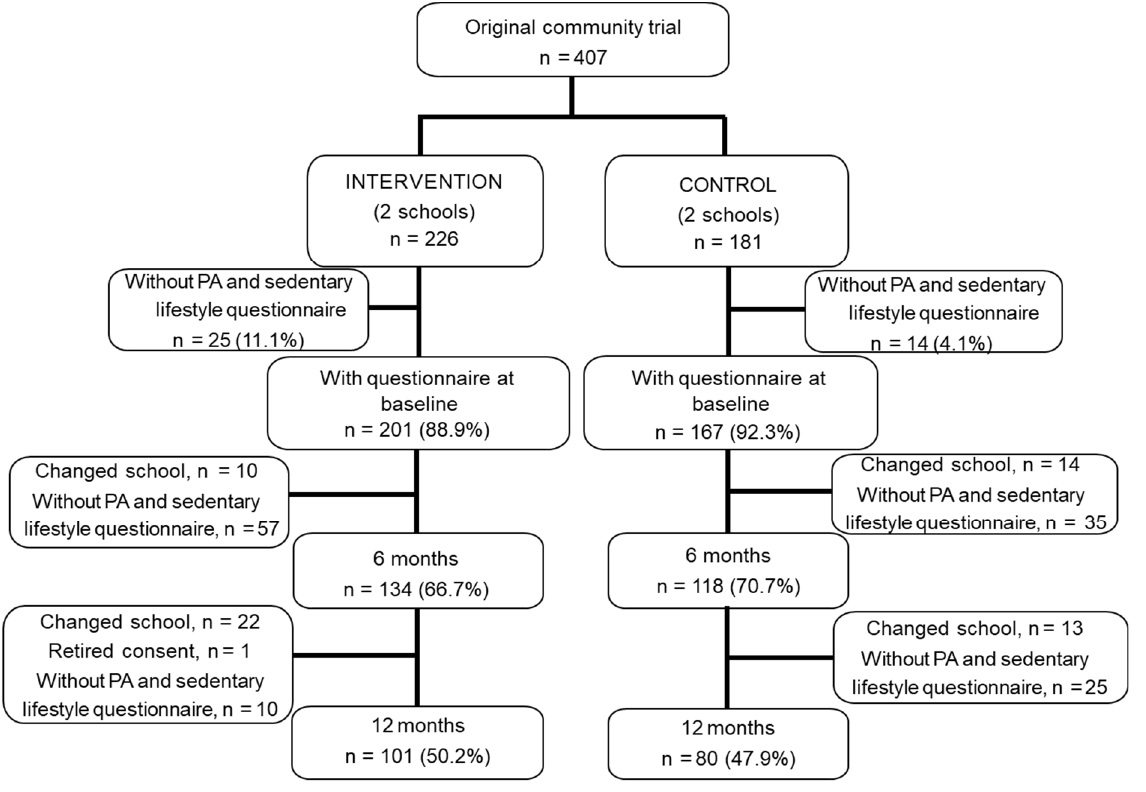
Figure 1. Flow of study participants. Table 1. General characteristics of the participants at